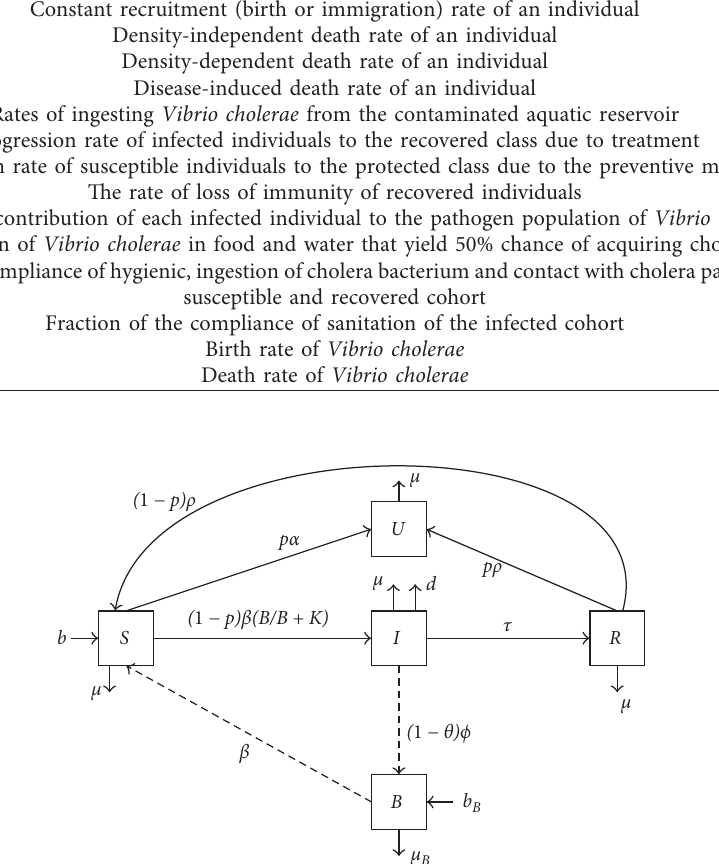
Table 1: Parameters for system of (1), where c is capita, l is litter, and T is time. Parameter